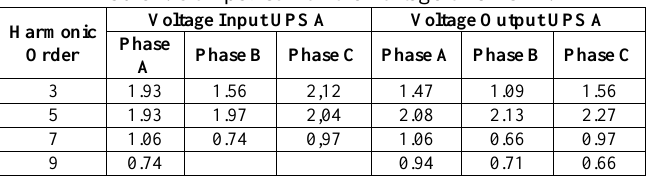
Table1: Comparison of the voltage of UPS A. Harmonic Order